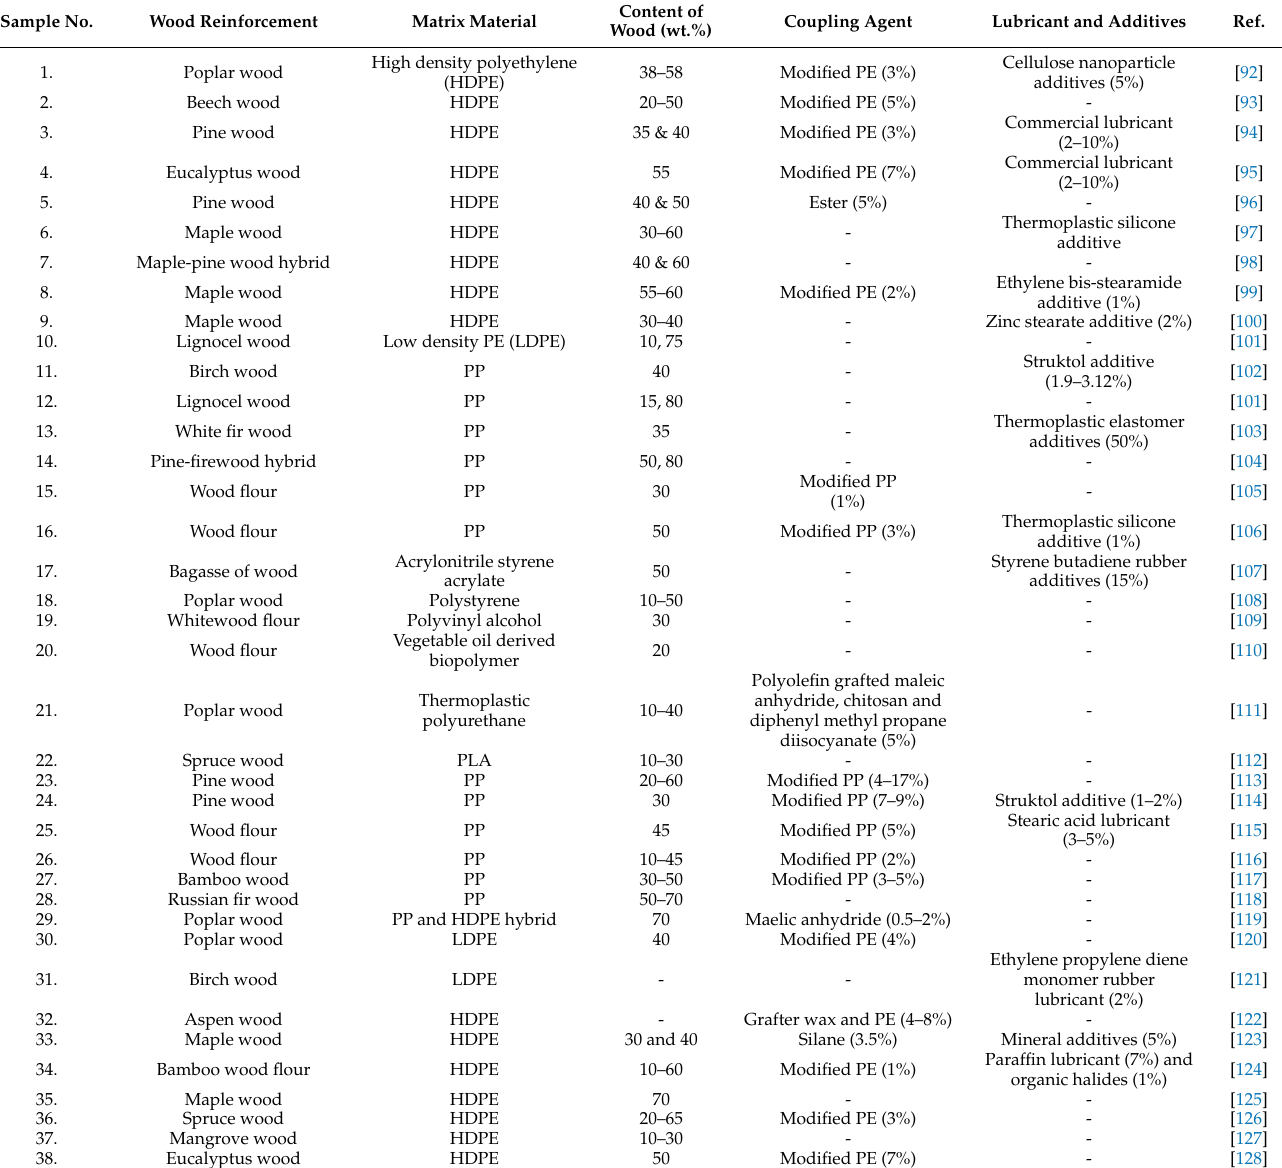
Table 1. Use of coupling agents, additives, and lubricants for manufacturing